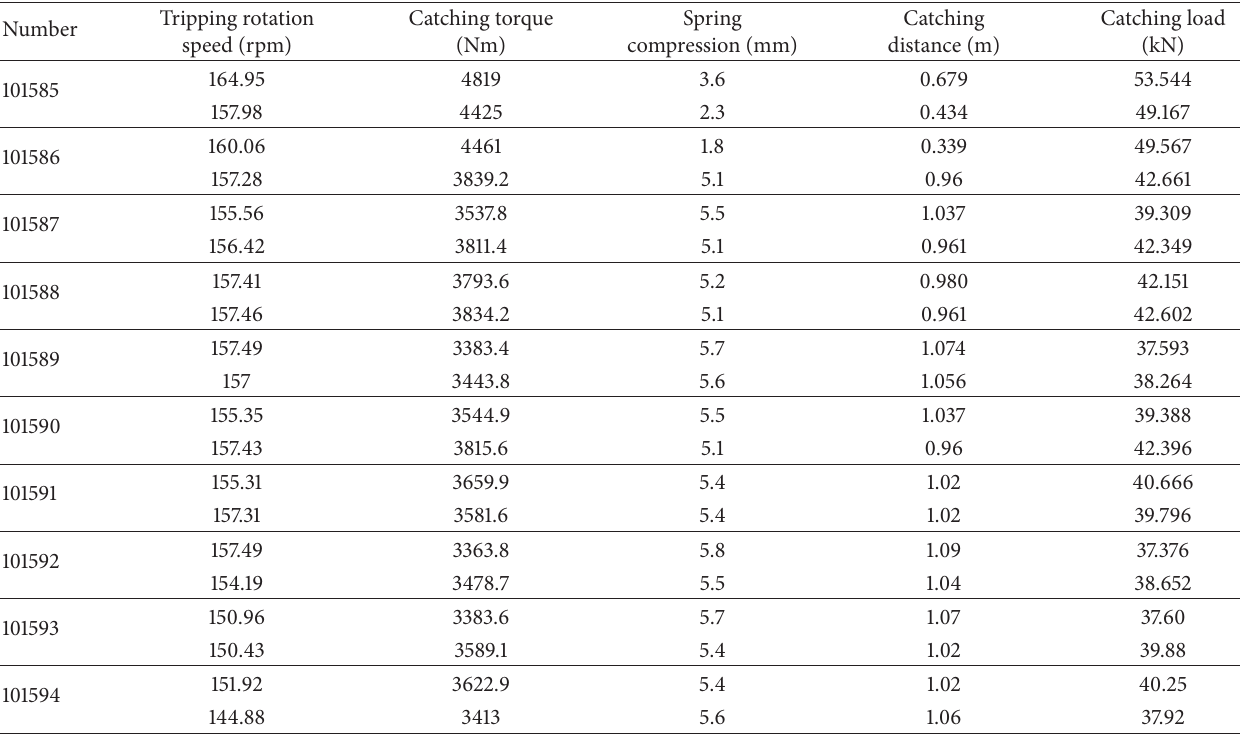
Table 11: The computed results with wavelet transform denoised